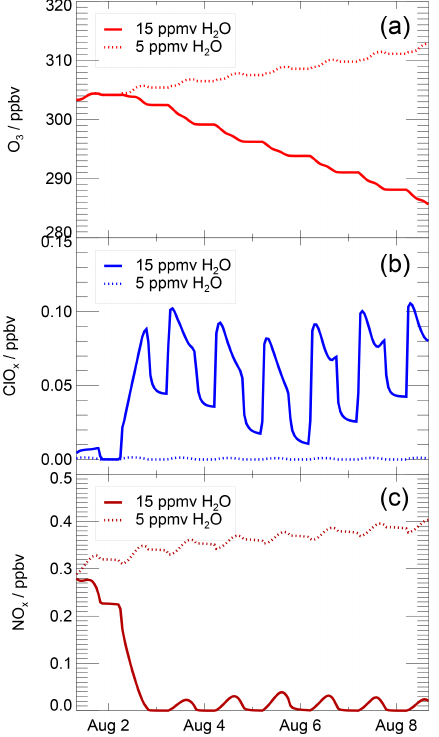
Figure 2. Volume mixing ratio of O 3 (a) , ClO x (b) and NO x (c) during a simulation with 15ppmv H 2 O and 5ppmv H 2 O. These water vapour mixing ratios are chosen because they are clearly in the regime of low (5ppmv) and elevated (15ppmv) water vapour. The x axis marks refer to 00:00 local time (06:00UTC).